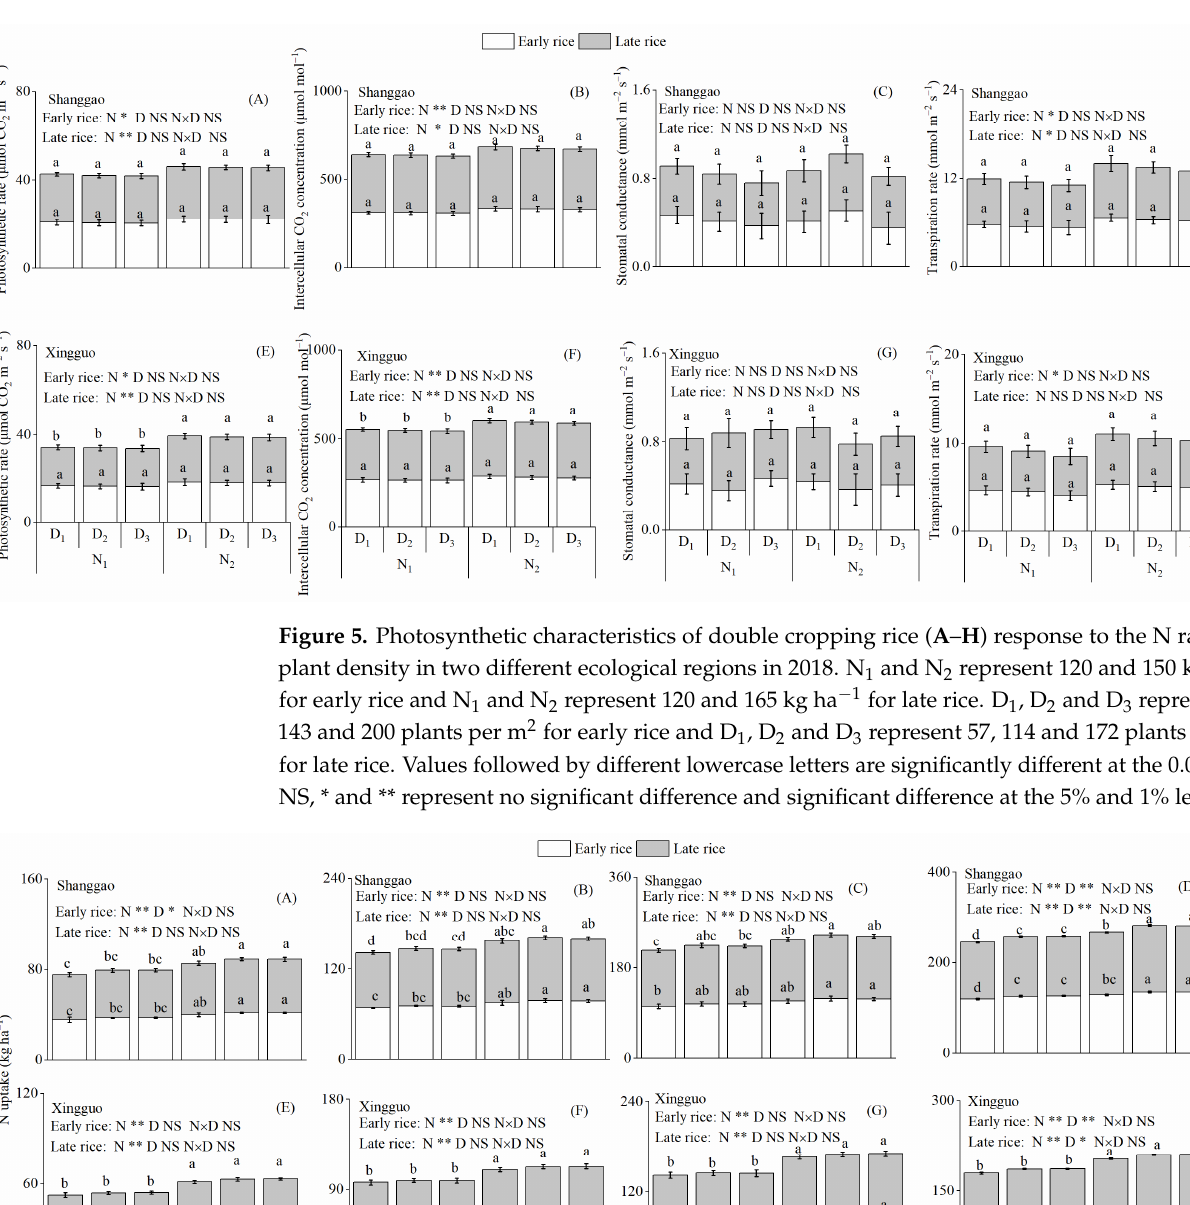
Figure 7. Phosphate absorption dynamics of double cropping rice ( A – H ) response to the N rate and plant density in two different ecological regions in 2018. N 1 and N 2 represent 120 and 150 kg ha -1 for early rice and N 1 and N 2 represent 120 and 165 kg ha -1 for late rice. D 1 , D 2 and D 3 represent 86, 143 and 200 plants per m 2 for early rice and D 1 , D 2 and D 3 represent 57, 114 and 172 plants per m 2 for late rice. Values followed by different lowercase letters are significantly different at the 0.05 level. NS, * and ** represent no significant difference and significant difference at the 5% and 1% levels.